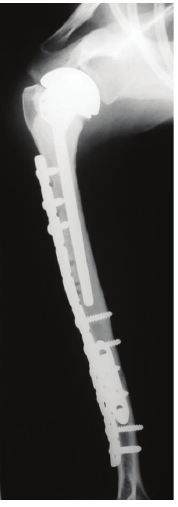
Figure 4: Anteroposterior radiograph 16 years after distal radius osteoarticular reconstruction. Although degenerative changes are evident, the patient is asymptomatic with excellent